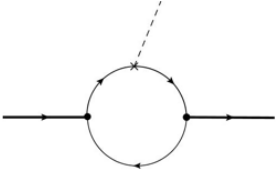
Figure 1 . The Feynman diagram for the matrix element B